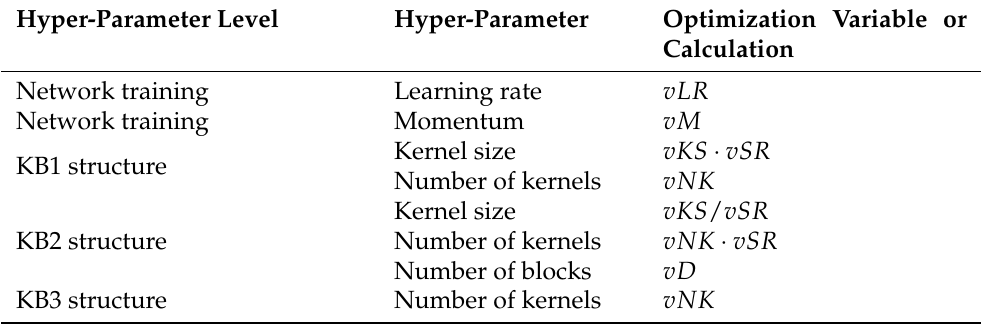
Table 3. Hyper-parameter calculation using optimization